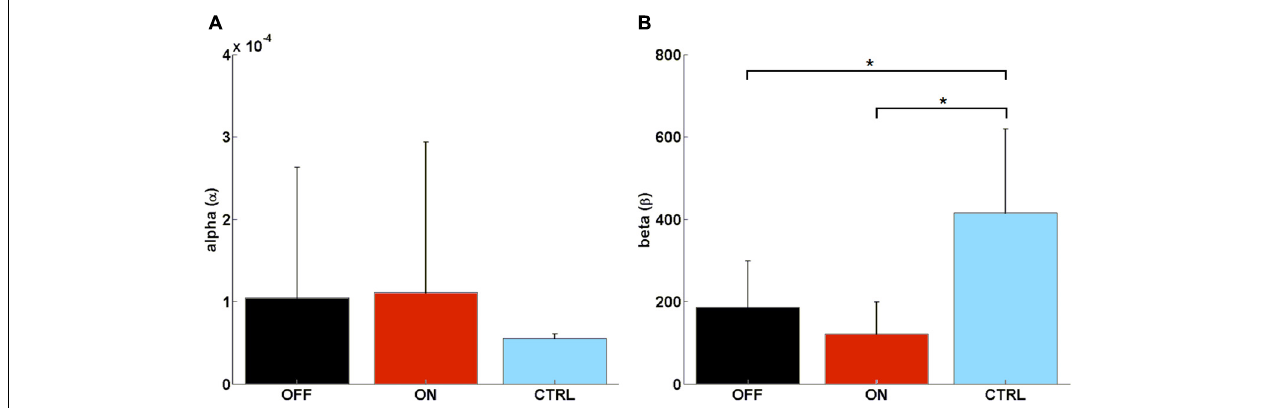
FIGURE 4 | Computed parameters of the Rescorla–Wagner Model: (A) mean rate of learning ( α ), (B) mean decision parameter ( β ). Such parameters were calculated by using a grid search approach when considering initial interval values [0.600] and [0, 0.0001] for β and α , respectively. ∗ means statistically significant difference.